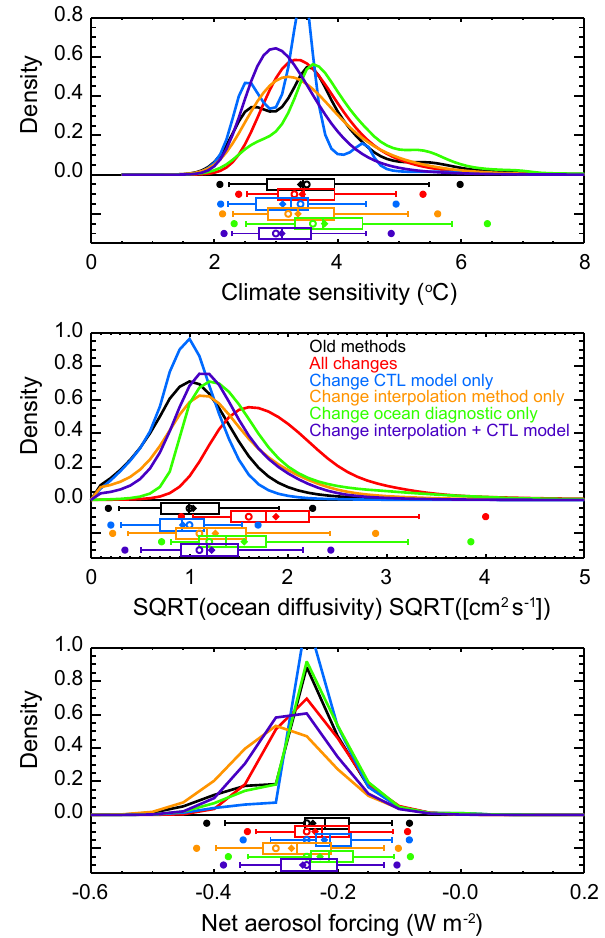
Figure 6. Marginal probability distribution functions for (a) ECS, √ K v , and (c) F aer derived with changes in methodology. A (b) comparison between the HadCRUT3 distribution derived in Libar- doni et al. (2018a) (black) with those derived using all changes outlined in the text (red) and individual changes to the control run used to estimate natural variability (blue), the ocean diagnos- tic (green), and the interpolation method (orange). Also shown is the case where the natural variability estimate and interpolation method are changed together (purple). Whisker plots indicate boundaries for the 2.5th–97.5th (dots), 5th–95th (vertical bar ends), 25th–75th (box ends), and 50th (vertical bar in box) percentiles. Distribution means are represented by diamonds and modes are represented by open